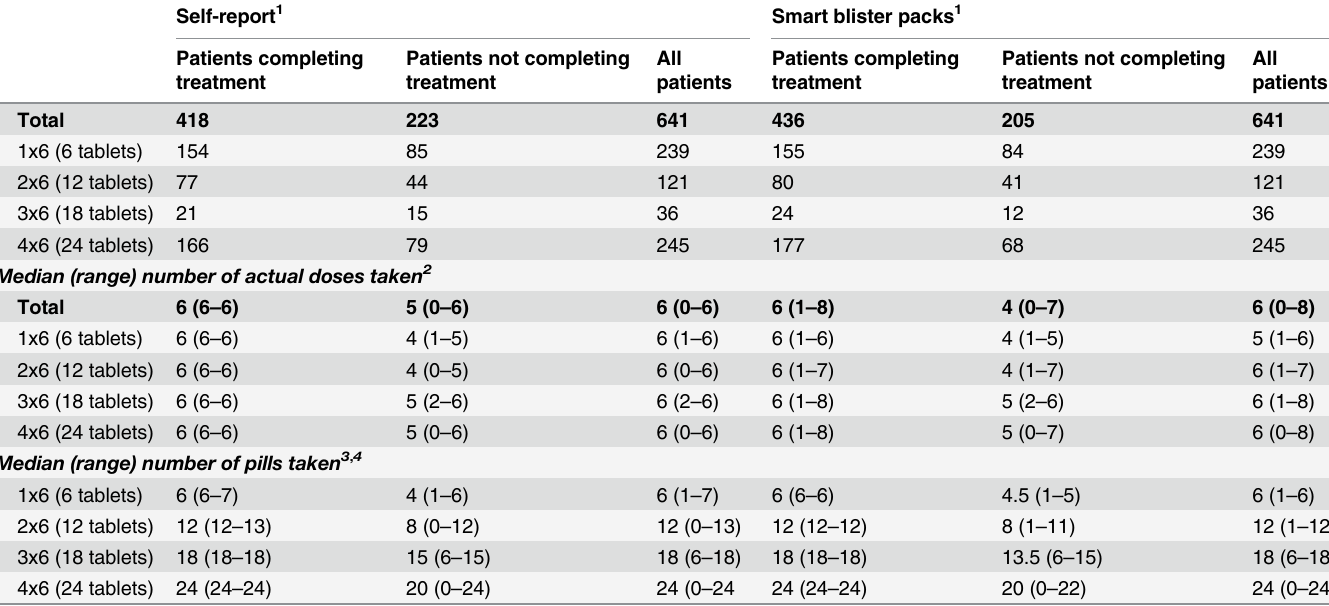
Table 4. Median number of actual doses and pills taken by self-report and smart blister packs 1